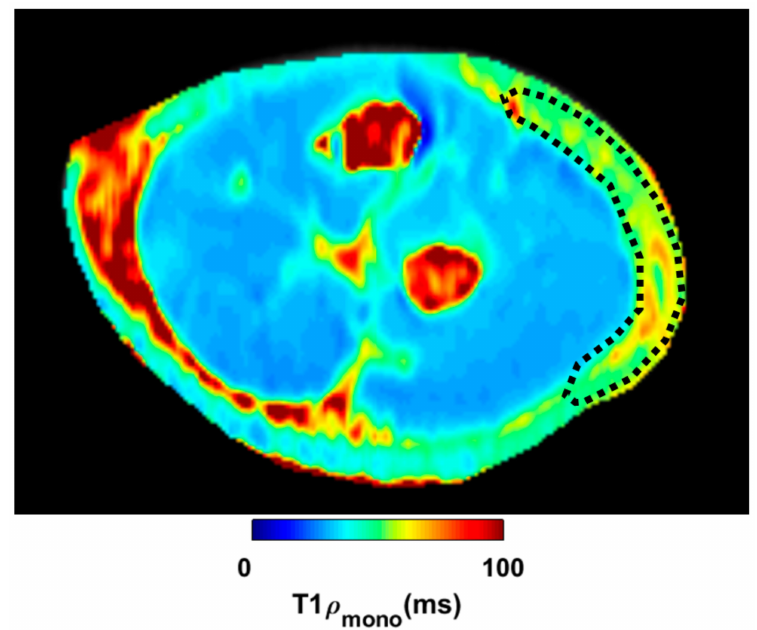
Figure 3. Region of interest (ROI) in one slide post-treatment. The ROI is the black line located below the skin at the level of the deep fascia in this transversal section of the forearm.